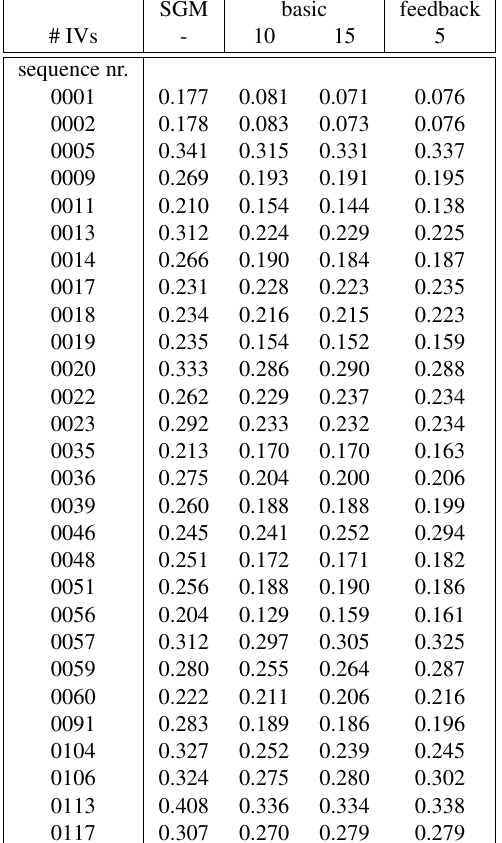
Table 8. Outlier ratios for select sequences of the KITTI raw data recordings. The sequences used are 2011_09_26_drive_xyzw, with the sequence number xyzw given above. All RGDF vari- ants use a color dissimilarity threshold of